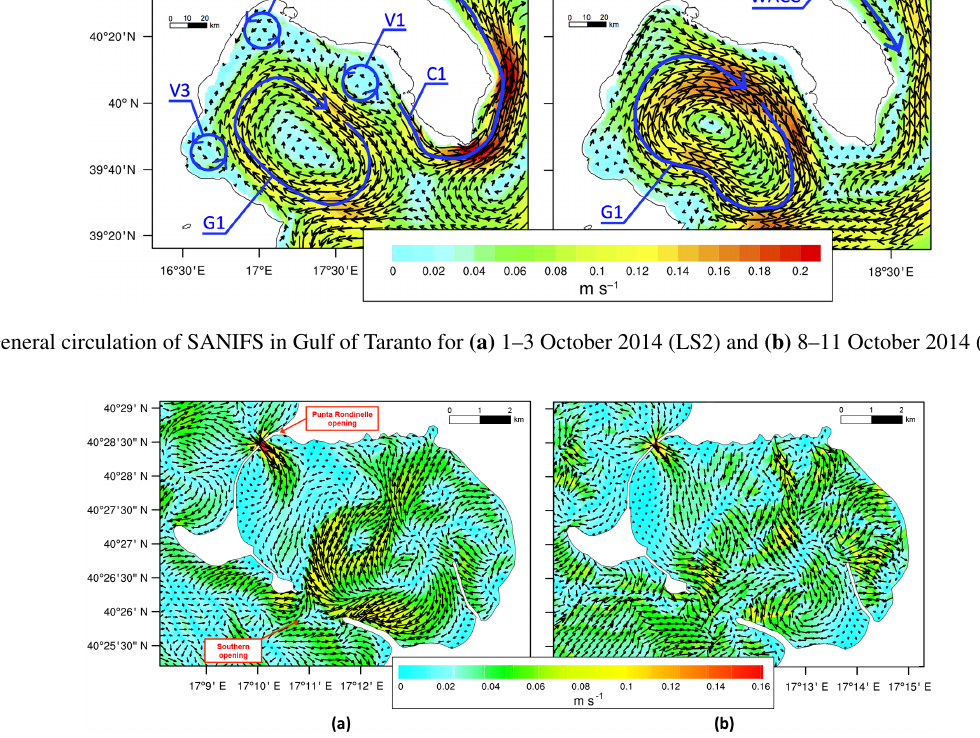
tively. The tidal analysis report errors of 6.2 and 14.1 % for amplitude and phase of K1 component and errors of 2.4